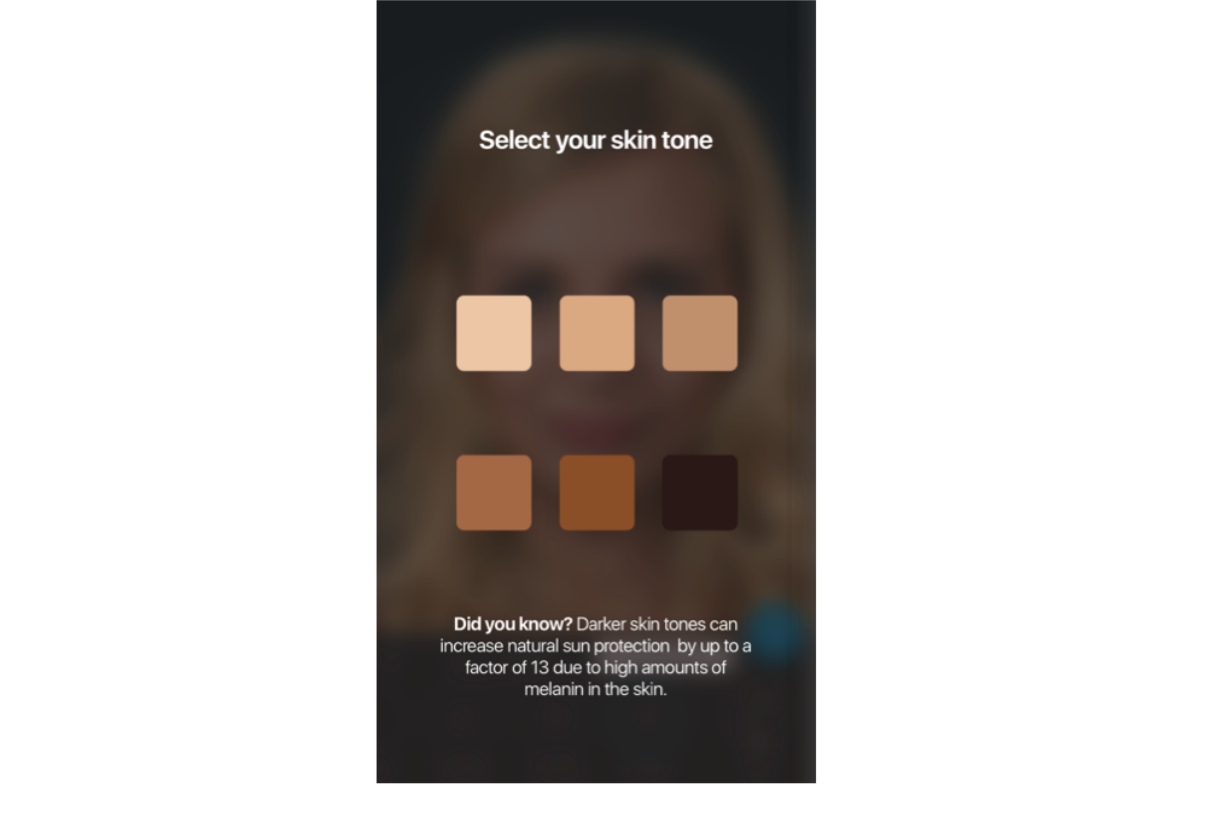
Figure 1. Start of the app: the user picks their Fitzpatrick skin type.